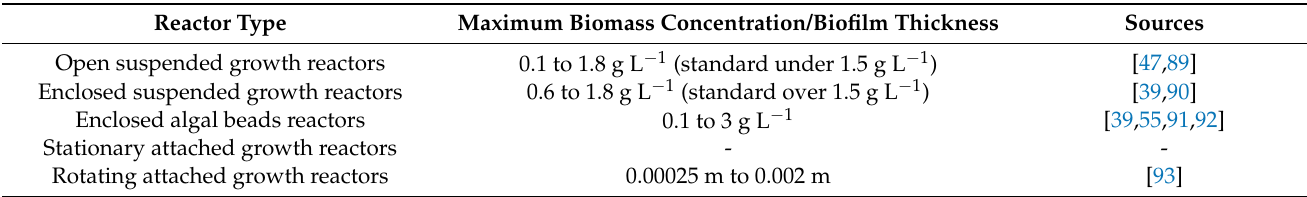
Table 3. Maximum biomass concentration/biofilm thickness of the main reactor